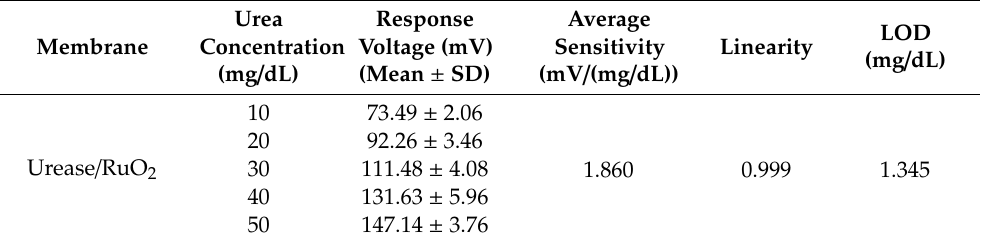
Figure 6. The results of the sensing measurement of the flexible arrayed RuO 2 urea biosensor. Table 1. The sensing characteristics of the flexible arrayed RuO 2 urea biosensors over a urea concentration ranging from 10 mg / dL to 50 mg / dL.